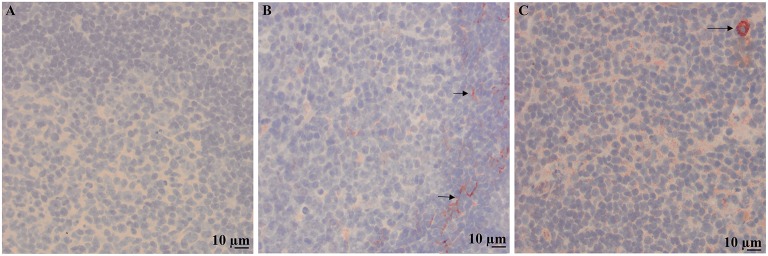
Immunolabeling of a reactive lymph node with benign follicular hyperplasia. 200X images of representative sections demonstrating no staining with the isotype control (A), staining for LDL-R on cytoplasmic processes of dendritic cells in the mantle zone of a follicle (arrows) (B) and weak punctate staining of low numbers of lymphocytes and strong staining of macrophages (arrow) for SR-B1 (C).